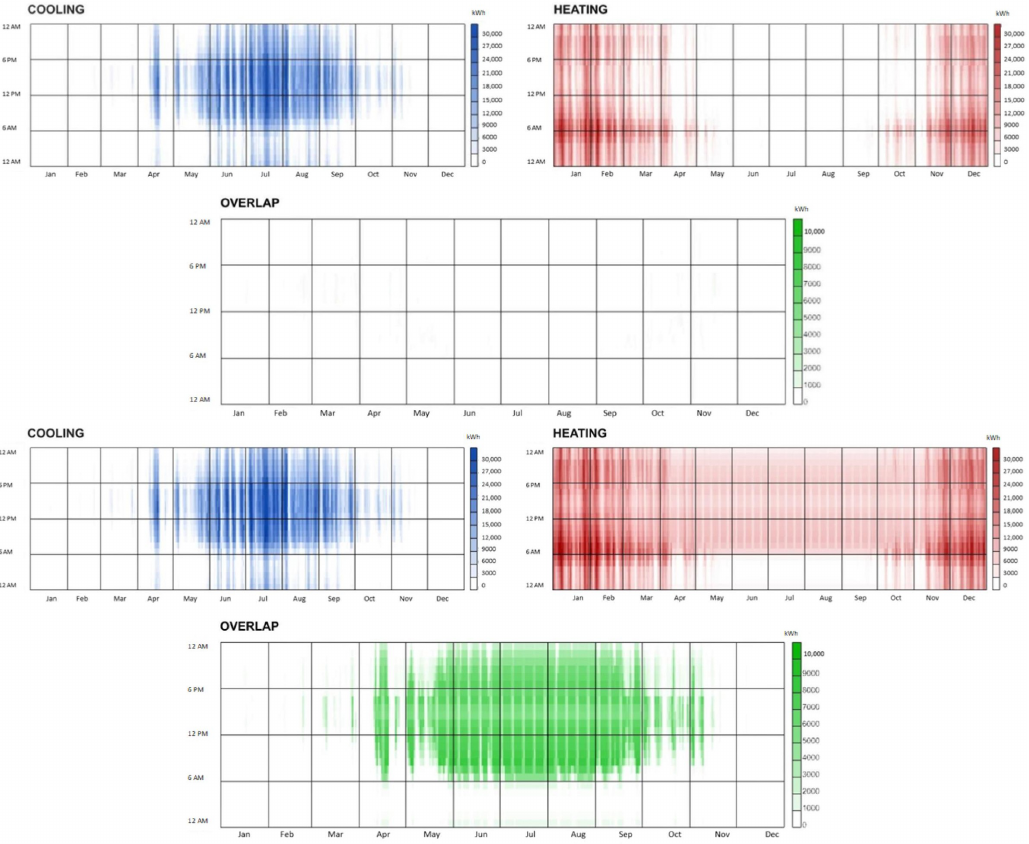
Figure 15. Thermal overlap considerations with and without service hot water and retail